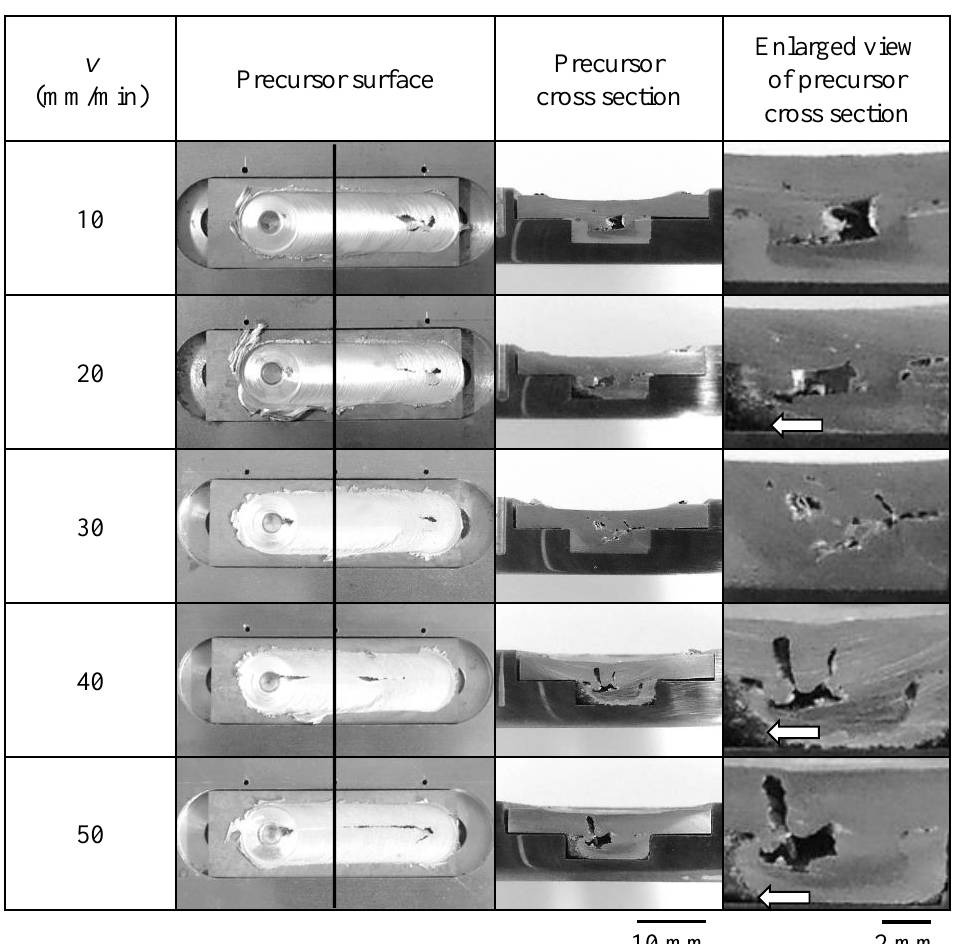
Figure 8. Surfaces and cross sections of precursors at various v .